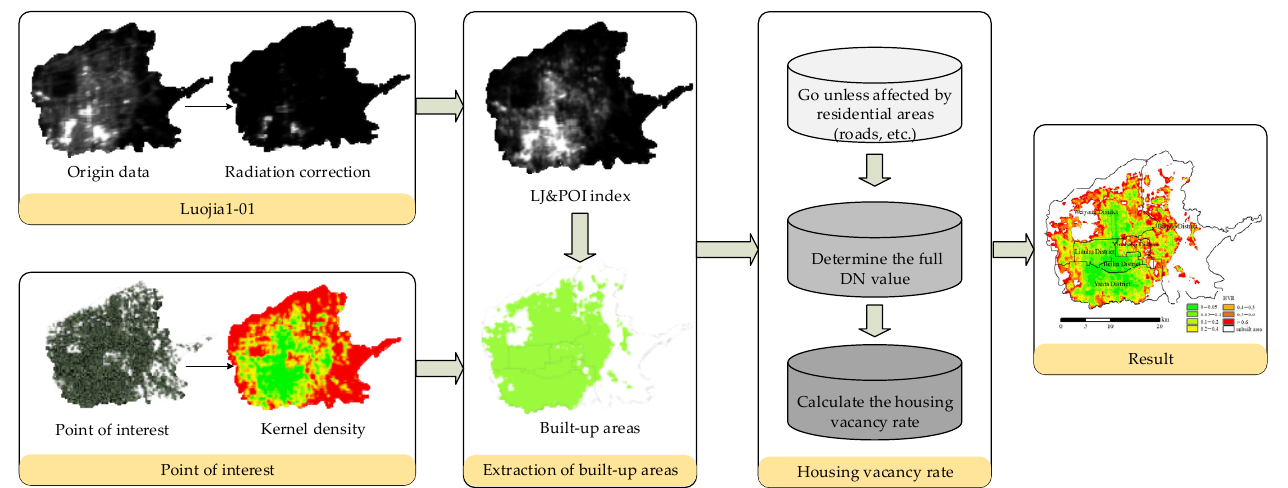
Figure 2. Workflow diagram of the estimation of the HVR.